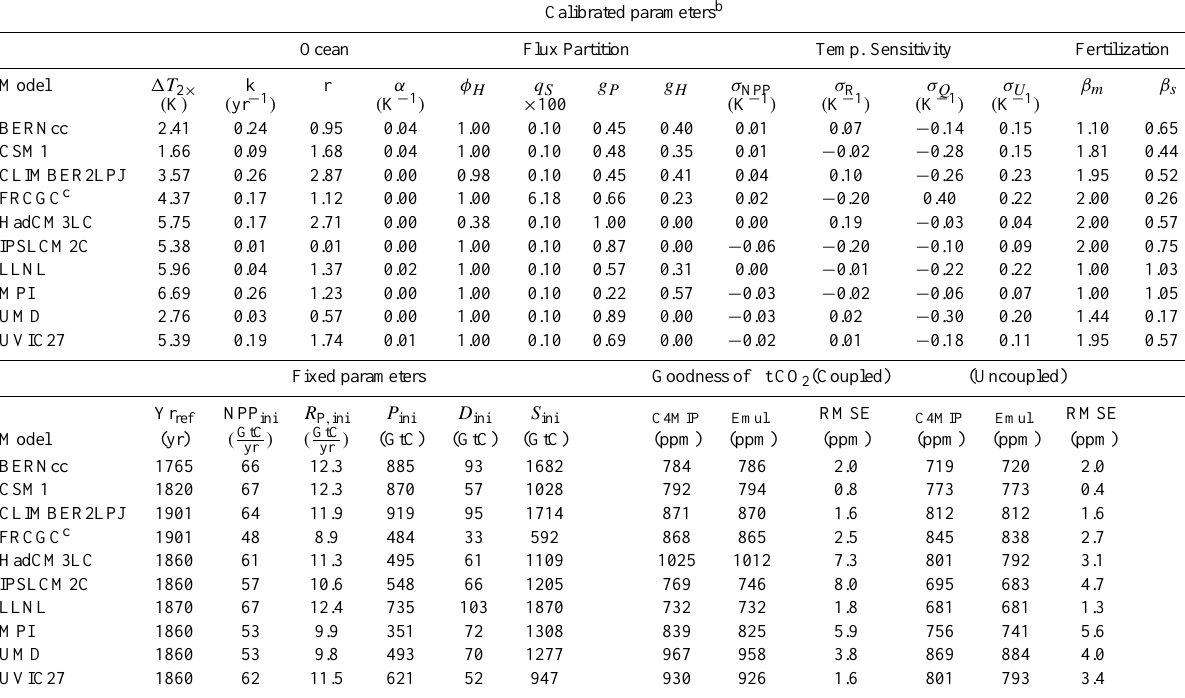
Table B4. C 4 MIP calibration: Calibrated and fixed MAGICC6 parameters required to emulate ten of eleven C 4 MIP carbon cycle models. The upper part of the Table lists calibrated parameters for MAGICC’s ocean and terrestrial carbon cycle, with the latter including four parameters for the carbon flux partitions, four temperature sensitivity parameters and two parameters determining fertilization behavior. The lower part of the Table provides the applied fixed parameters during the calibration procedure, such as reference years for each model, from which their scenarios started (Yr ref ), initial carbon fluxes for net primary production (NPP ini ), the total heterotrophic respiration ( P R ini ), initial pool sizes for the plant box (P ini ), the detritus box (D ini ) and the soil box (S ini ). For both the coupled and uncoupled model runs, some goodness of fit statistics are provided: Atmospheric CO 2 concentrations are given for year 2100 for the original C 4 MIP data (C 4 MIP) and for the emulation by MAGICC (Emul.), as well as the root mean square error (RMSE) of concentrations over the whole 21st century (cf. Figs. 6 and B4) .